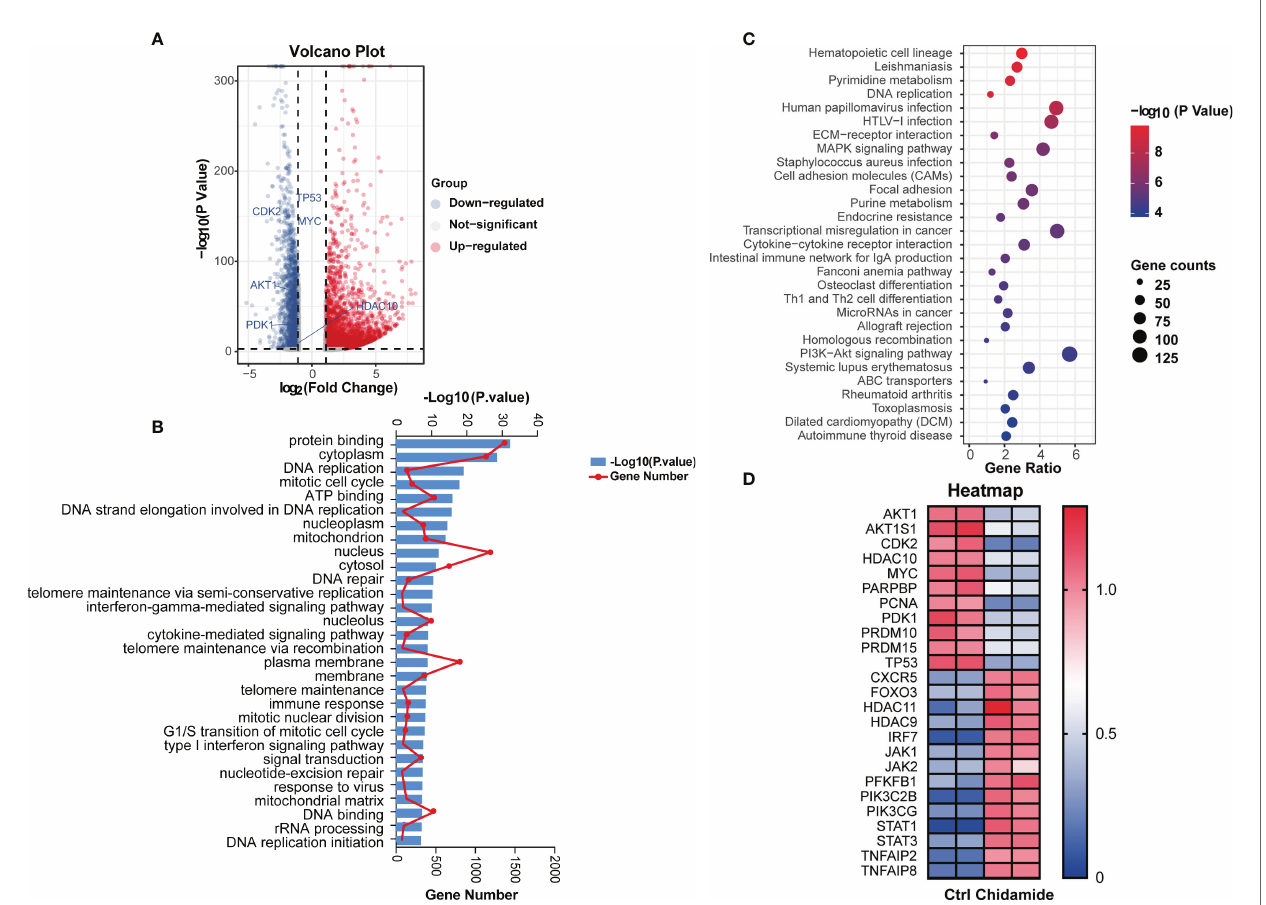
FIGURE 5 | Effects of chidamide in genome-wide gene expression and relative pathway in DOHH2 cells. RNA-seq was performed to pro fi le genome-wide gene expression in DOHH2 cells treated with 5 m M chidamide for 24 h. (A) Volcano plot depicting 4114 and 2095 genes signi fi cantly upregulated and downregulated compared with the DMSO control groups, respectively. (B) Gene Ontology (GO) enrichment analysis of DEGs was performed by Gene Set Enrichment Analysis (GSEA). Pathways affected by chidamide in the DOHH2 cell line. (C) Differential signaling pathways in KEGG pathway enrichment analysis showing genes involved in PI3K/AKT signaling were signi fi cantly enriched. (D) Heat map of differentially expressed genes in DOHH2 cells in response to chidamide for 24